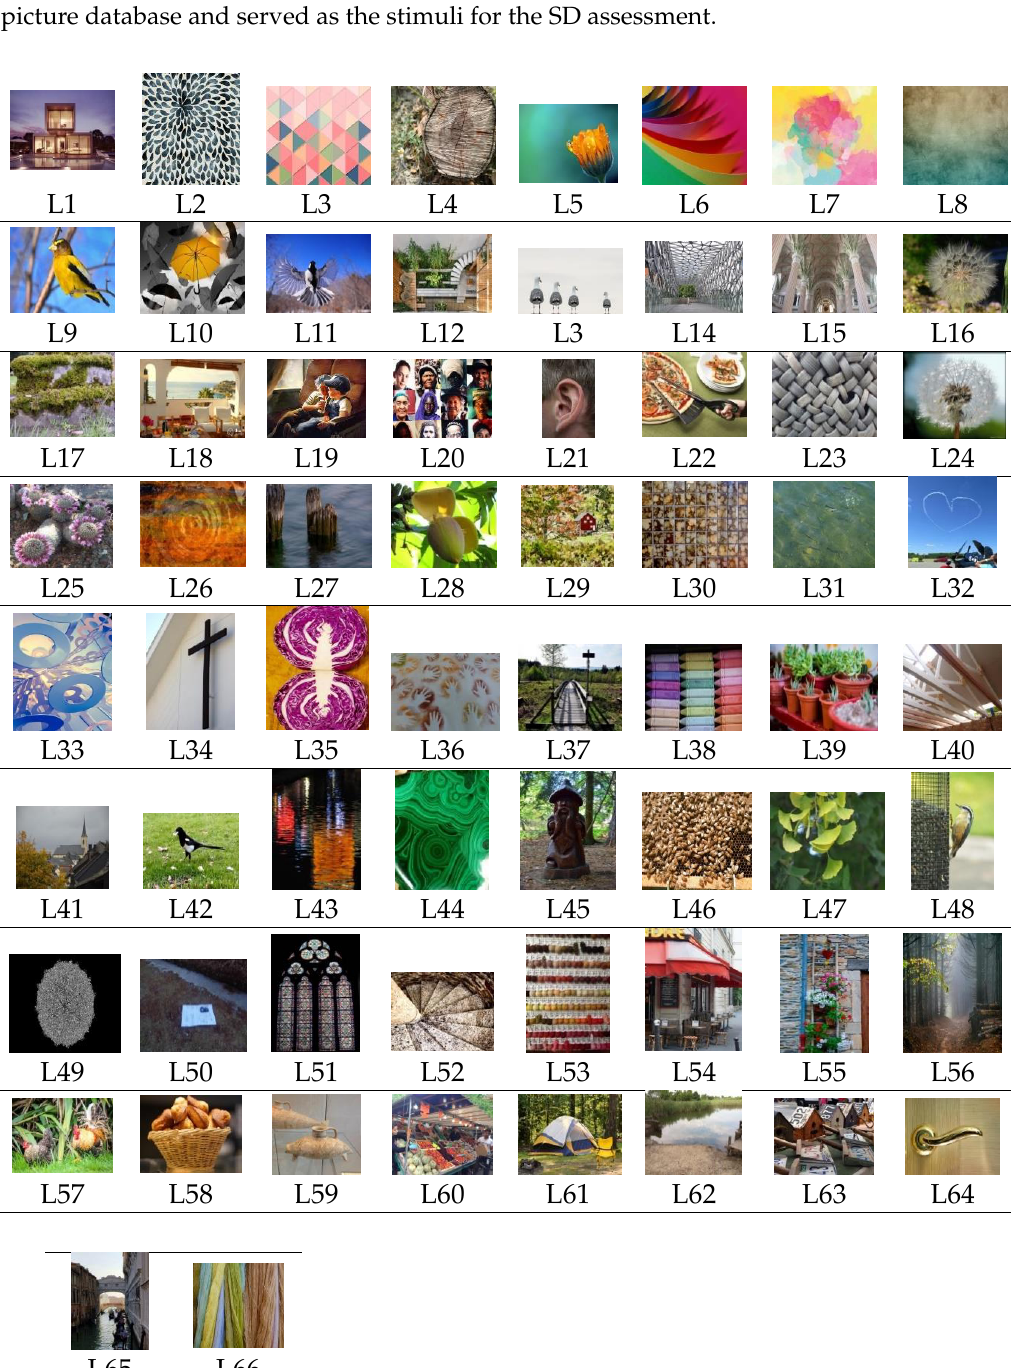
Figure 4. Stimuli of pictures for the LOHAS image (L1–L16 were proposed by designers and L17–L66 by the representative of LOHAS).